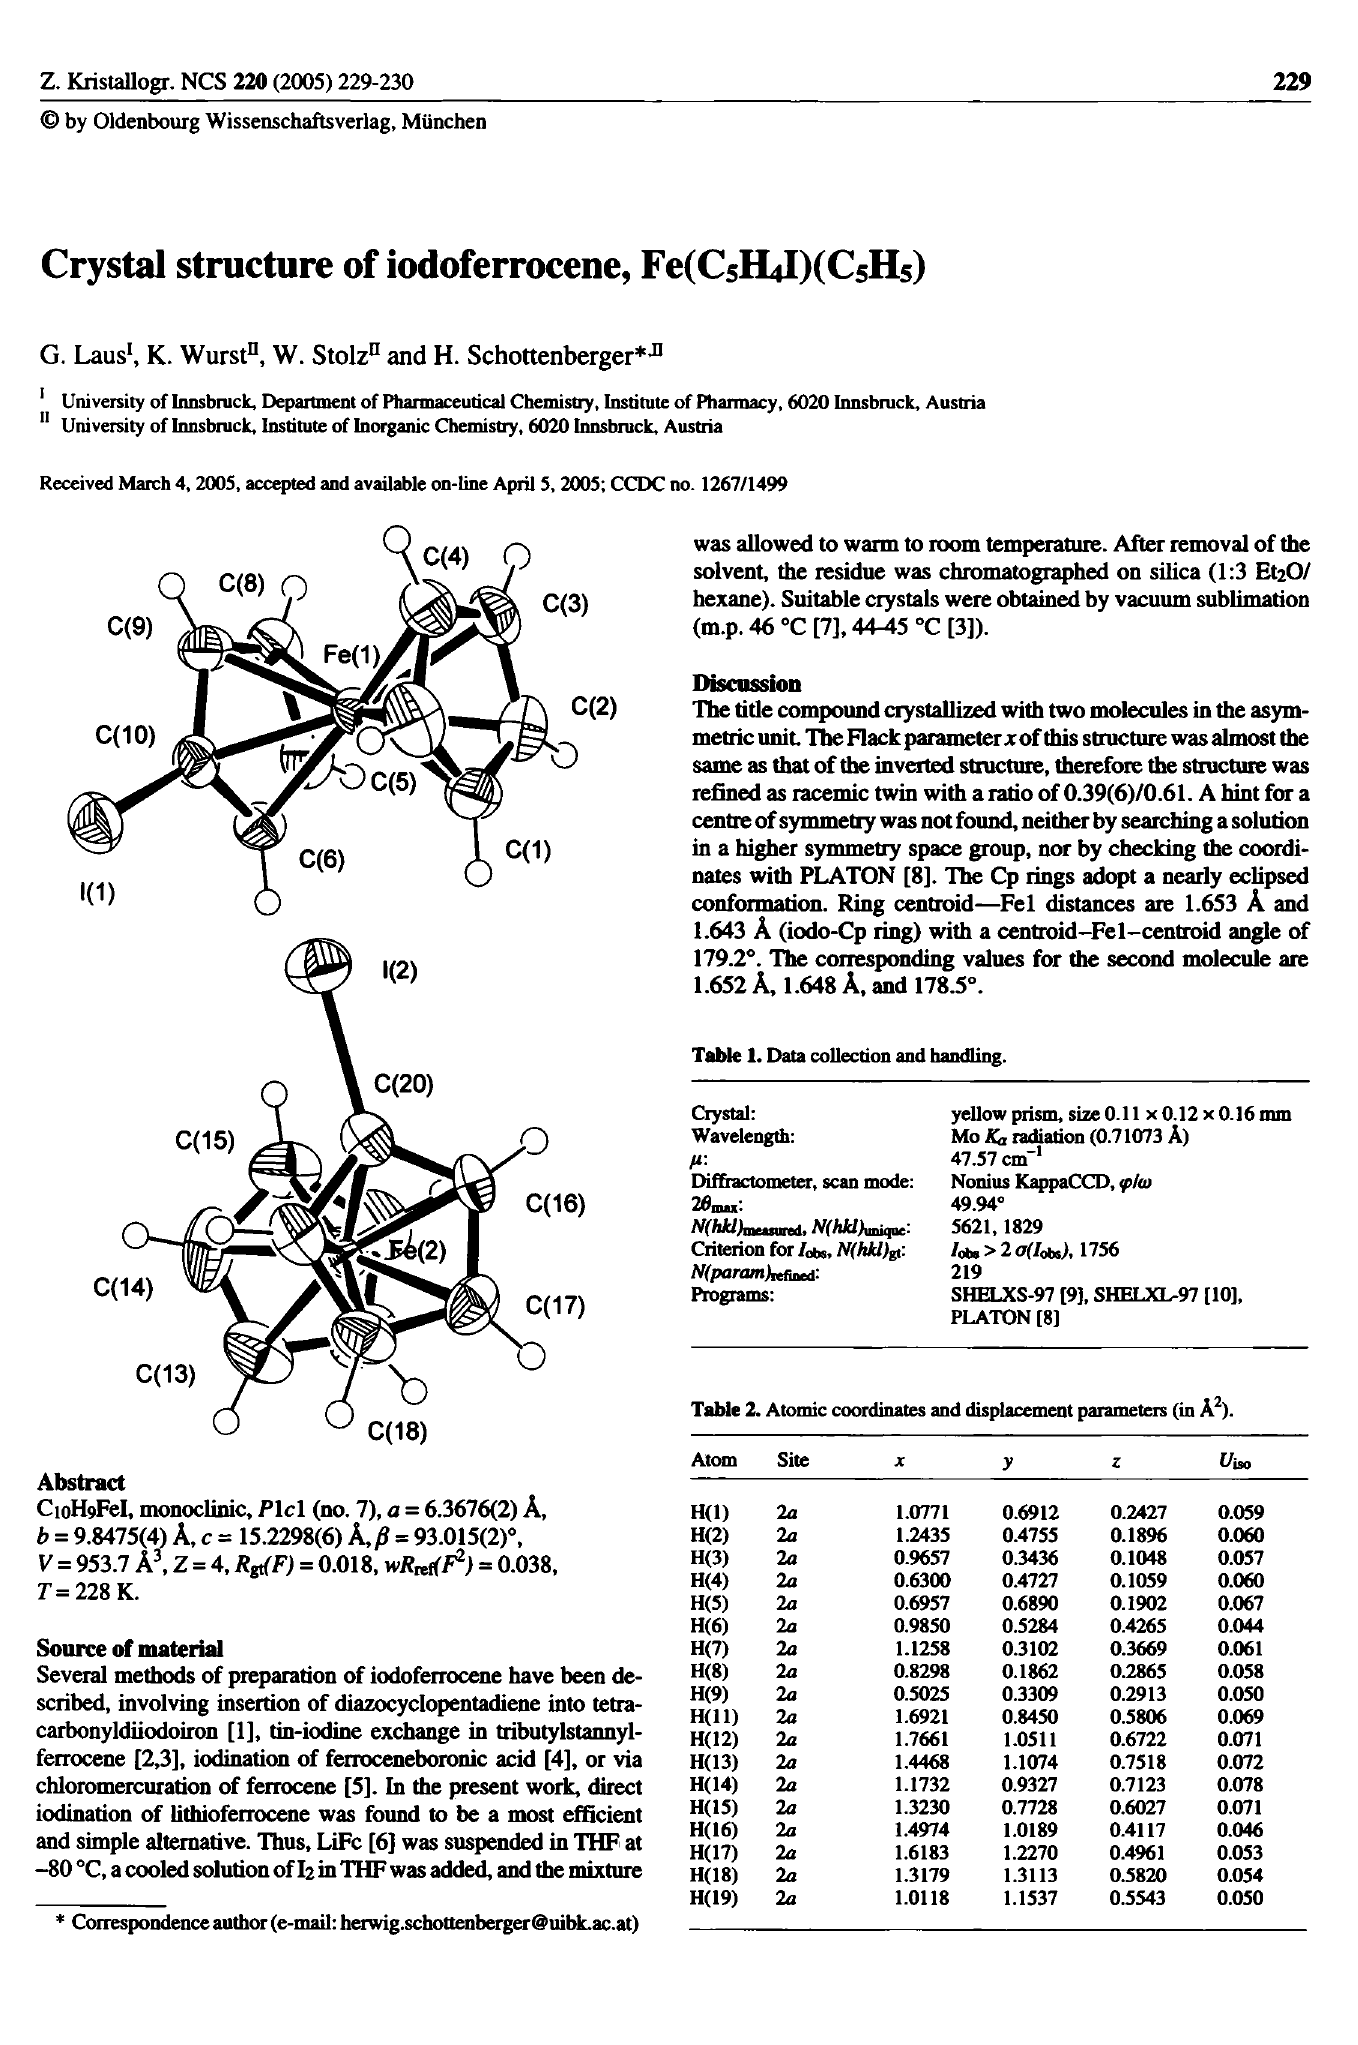
Table 2. Atomic coordinates and displacement parameters (in A 2